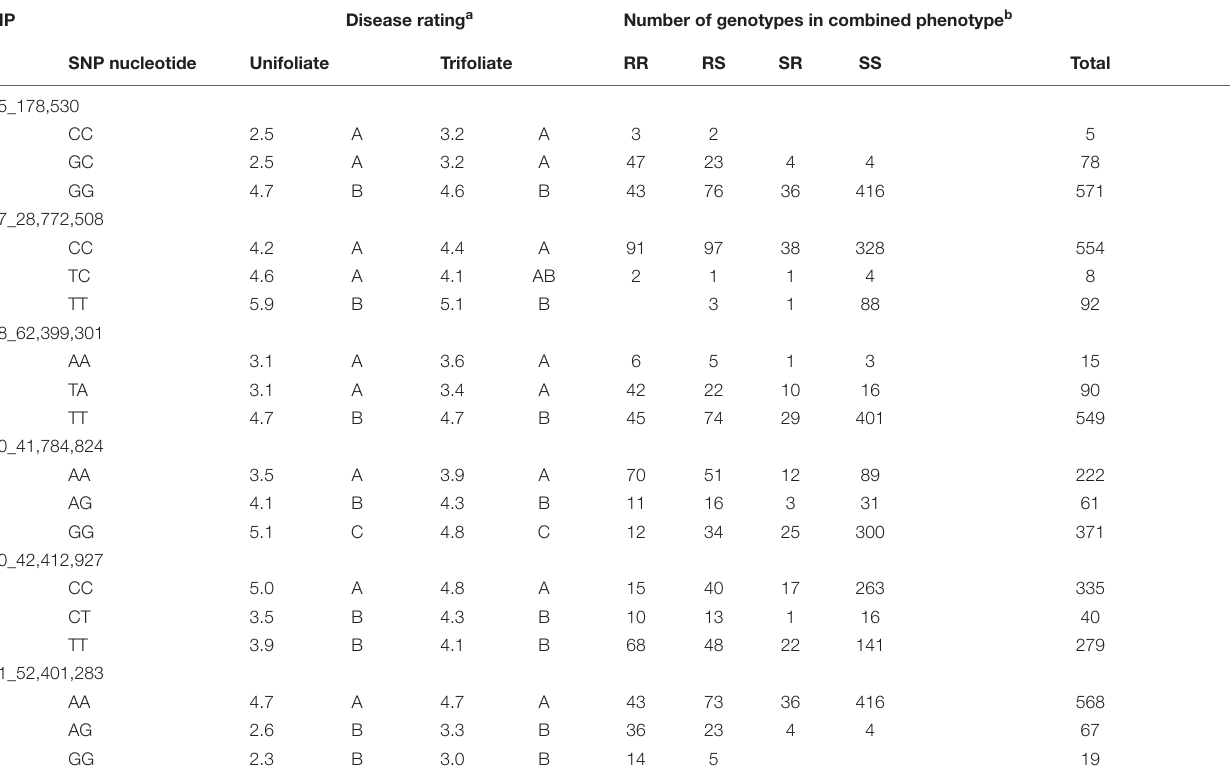
TABLE 4 | Relationship between the allelic state of peak single-nucleotide polymorphisms (SNPs) and their utility in marker-assisted breeding in the Middle American breeding population for SNPs identified by at least two of the three analyses. SNP Disease rating a Number of genotypes in combined phenotype